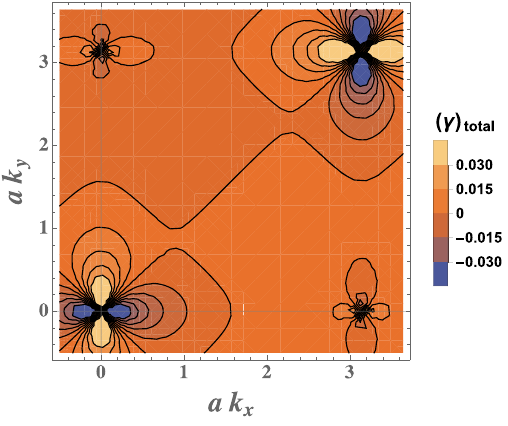
k Þ for the C 2 total ð